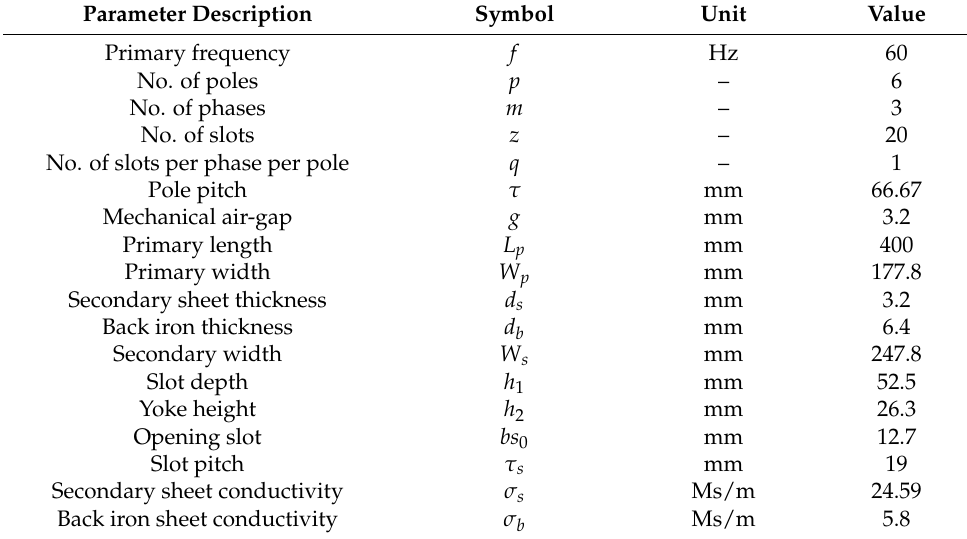
Table 1. Structure parameters of the